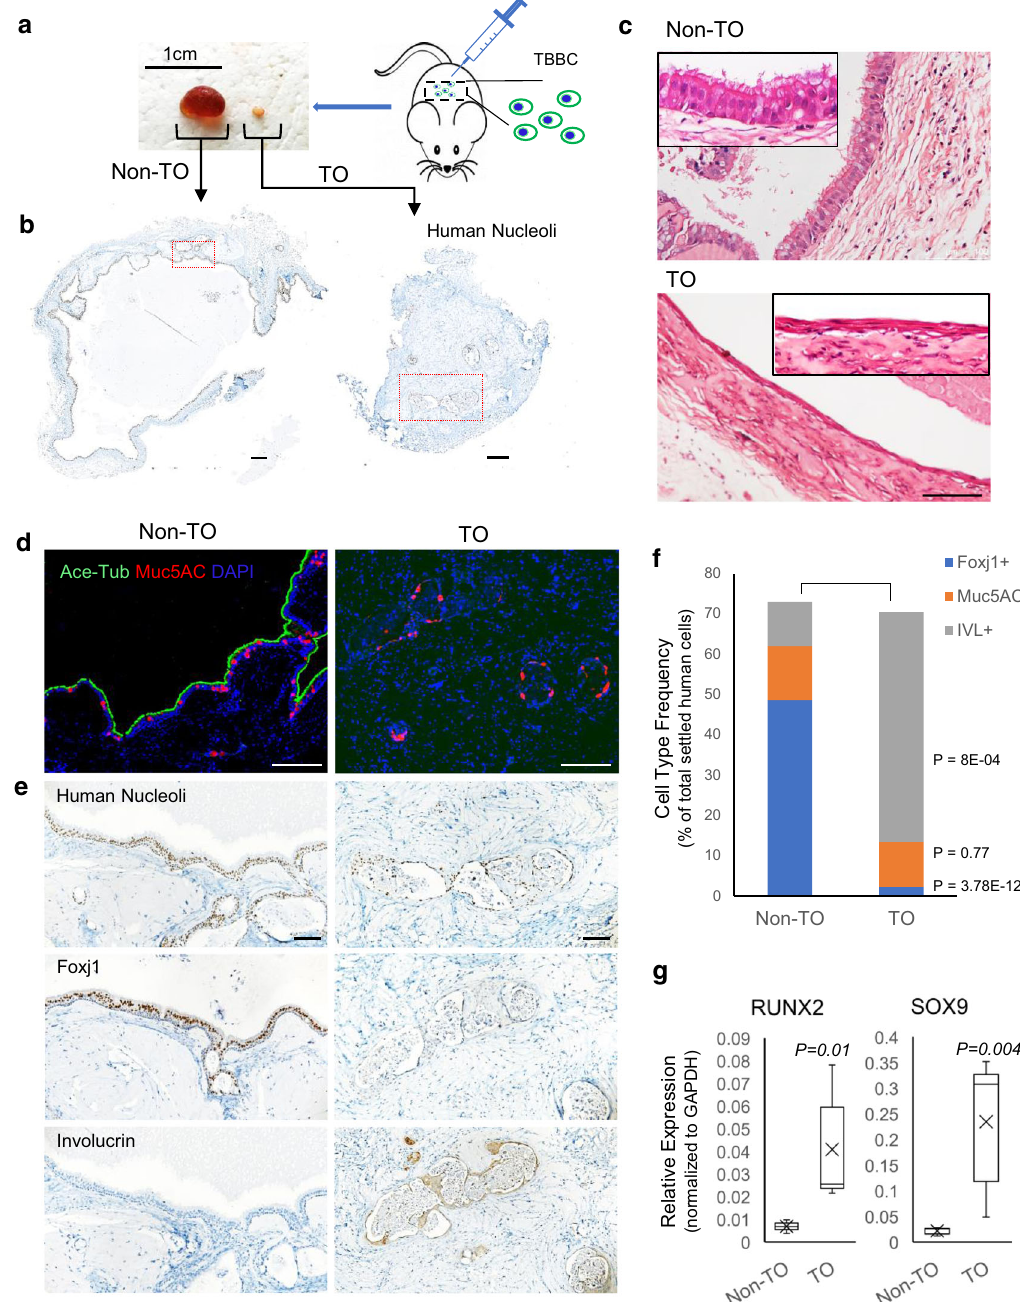
Fig. 3 In vivo differentiation of TO-derived basal cells. a Xenografts were standardly collected at 4-week post subcutaneous injection of 3 × 10 6 cells/spot on immunode fi cient NSG mice. b Transplanted cells were distinguished from the host by immunohistochemical staining with anti-human nuclei. Scale bar, 250 μ m. The red outlined boxes are the magni fi ed regions shown in ( d – e ). c Hematoxylin-eosin (HE) staining of xenografts derived from control- and TO- basal cells. Scale bar, 100 μ m. d , e IF and immunohistochemical (IHC) staining of functional cell markers Ace-Tub (ciliated), Muc5AC (goblet), Foxj1 (ciliated precursor), and Involucrin (squamous) on sequential xenograft sections. Scale bar, 100 μ m. f Quanti fi cation of differentiation frequencies of basal cells from control and TO groups (non-TO n = 7 and TO n = 10 biologically independent experiments). Results are represented as mean ± SD, and p values are indicated to show statistical signi fi cance based on two-tailed Student ’ s t -tests. g Real-time PCR measurement of RUNX2 and SOX9 expression on control- and TO-basal cell-derived xenografts ( n = 3 biologically independent samples/group, 2 experimental repeats/sample). Boxes denote 25th and 75th percentile, lines denote median, crosses denote mean values, and whiskers min – max. P values are indicated to show statistical signi fi cance. Source data are provided as a Source Data fi